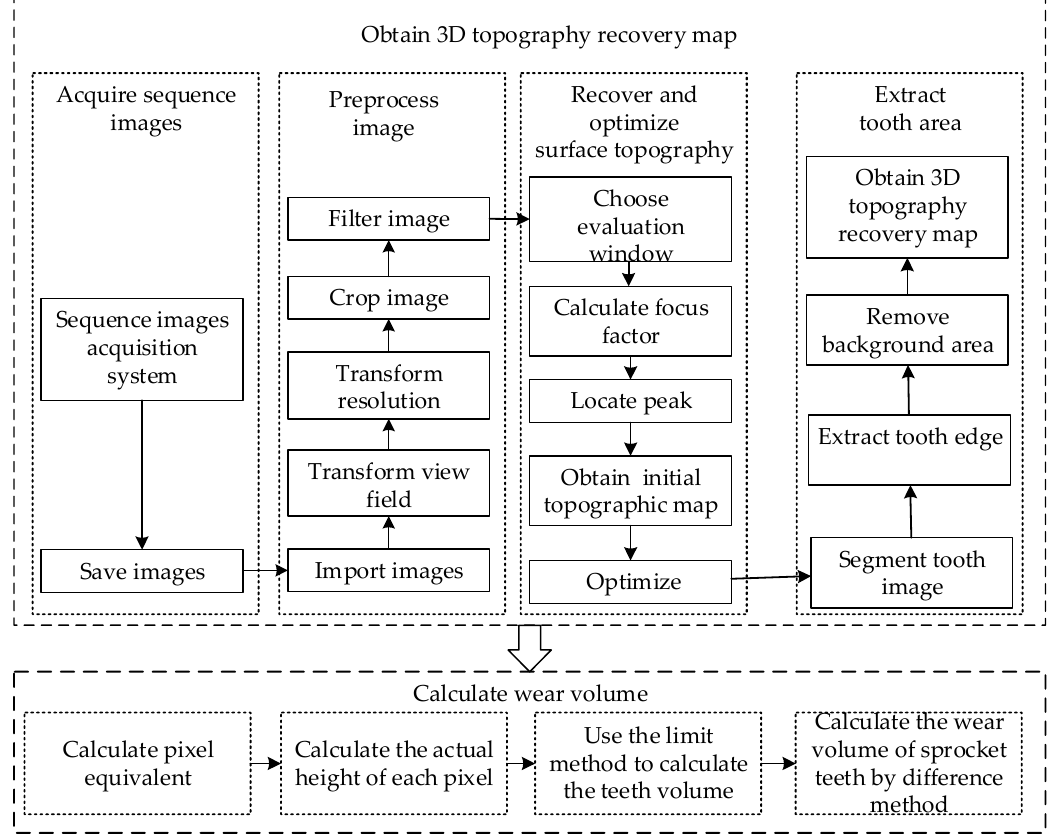
Figure 5. Flow chart of the focused morphology restoration algorithm.